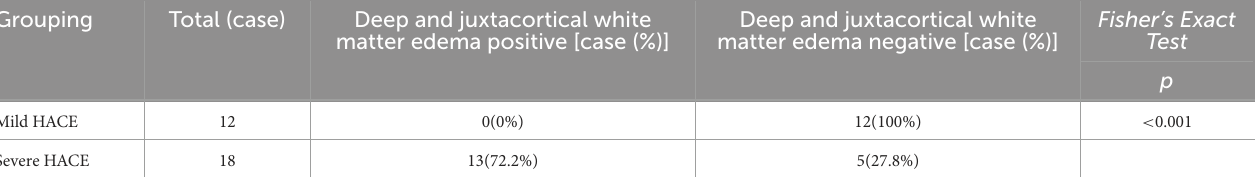
TABLE 5 Signal intensity distribution of mild HACE DWI sequence and MRI ordinary sequence in 12 cases. DWI